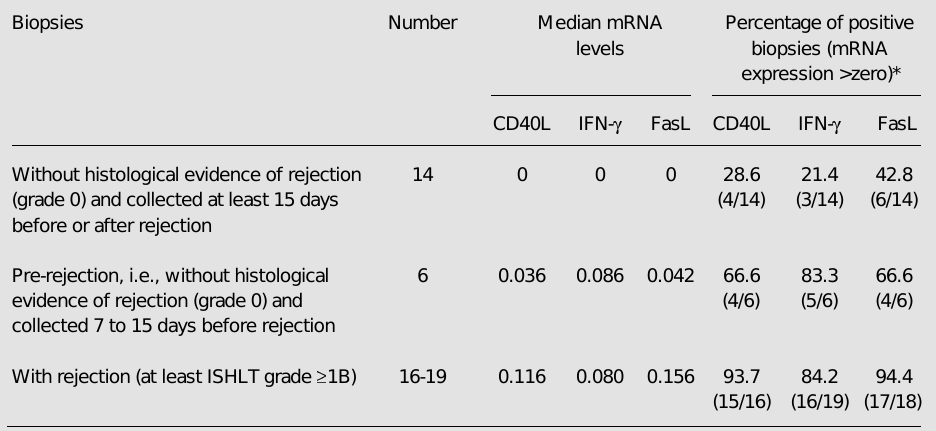
Table 1. CD40L, IFN- g , and FasL mRNA levels (target mRNA/ß-actin mRNA) in endomyocardial biopsies.